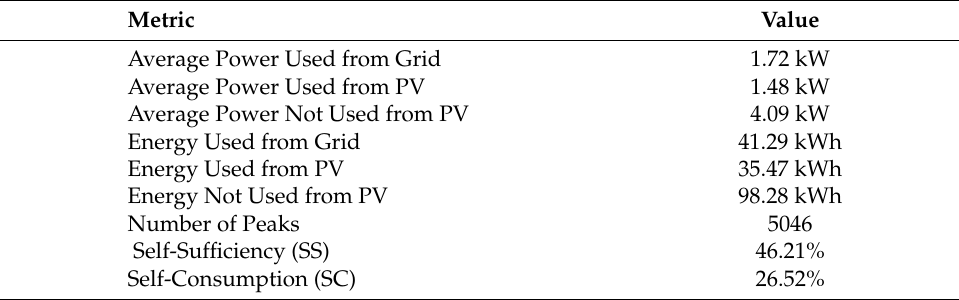
Table 2. Values obtained for the different metrics calculated in this EC